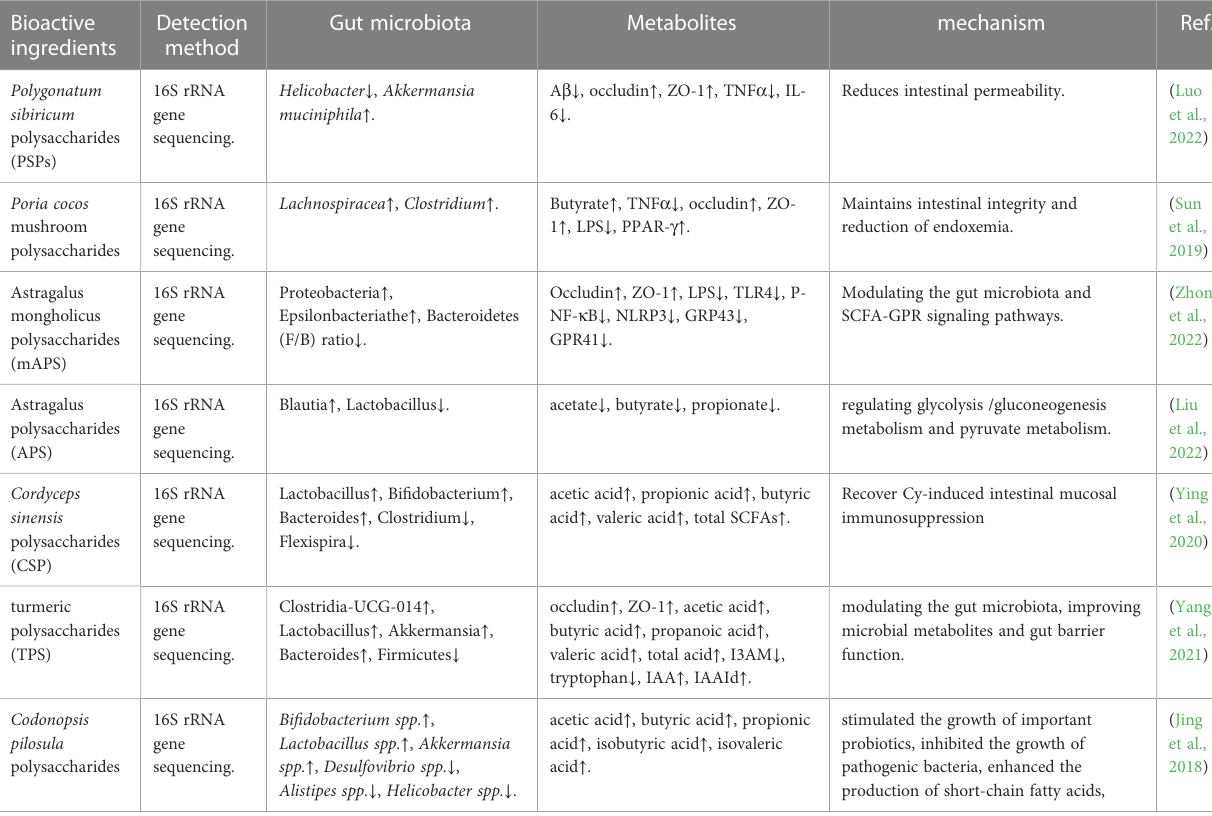
TABLE 1 The polysaccharides from TCM regulated gut